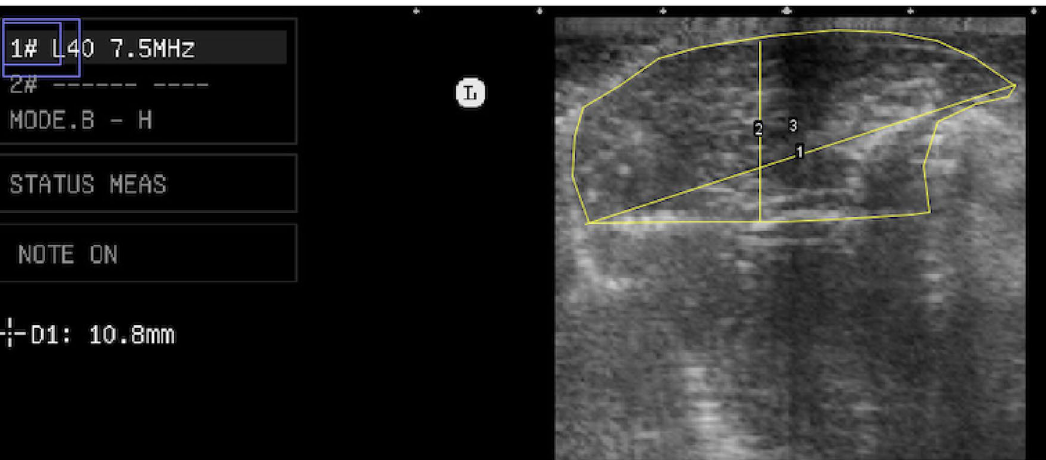
Figure 2. Image analysis using the ImageJ software the area (cm 2 ), length (cm) and depth (cm) of the M. pectoralis major in the transverse positions in domestic quail ( Coturnix japonica ). 1—pectoral muscle length (cm); 2—pectoral muscle depth (cm); 3—pectoral muscle area (cm 2 )—the entire area bounded by the outer